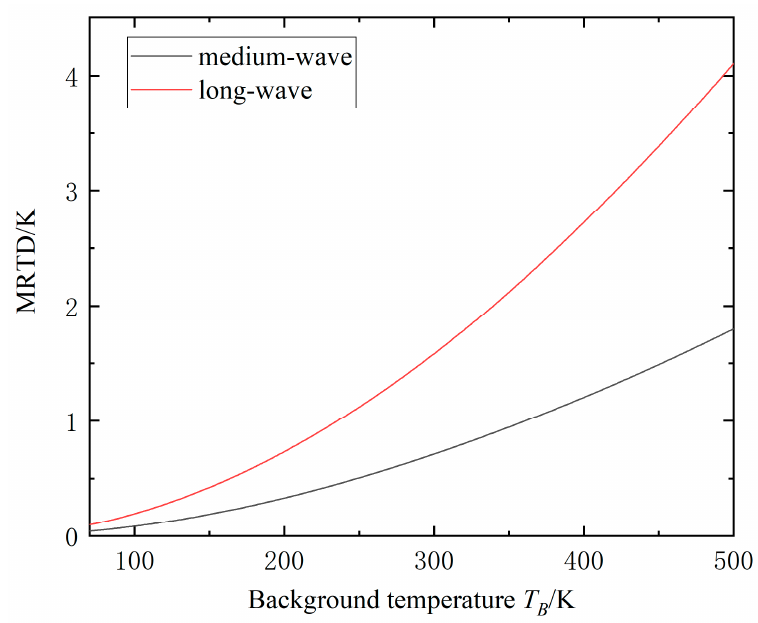
Figure 10. Relationship between background temperature T B and MRTD (ITD). Both Figures 9 and 10 show that the expressions of MRTD about f and T B are mono- tonically increasing functions. As the spatial frequency f and background temperature T B increase, MRTD also tends to increase monotonically. The temperature resolution ability of ITD under the medium-wave is better than the long-wave. For example, when the spatial frequency f = 0.2 cyc × mrad − 1 , the MRTD of the ITD in the long-wave and medium-wave are1520.7 mK and 682.9 mK . When T B = 300 K, the MRTD of the ITD in the long-wave and medium-wave are 1617.8 mK and 721.3 mK